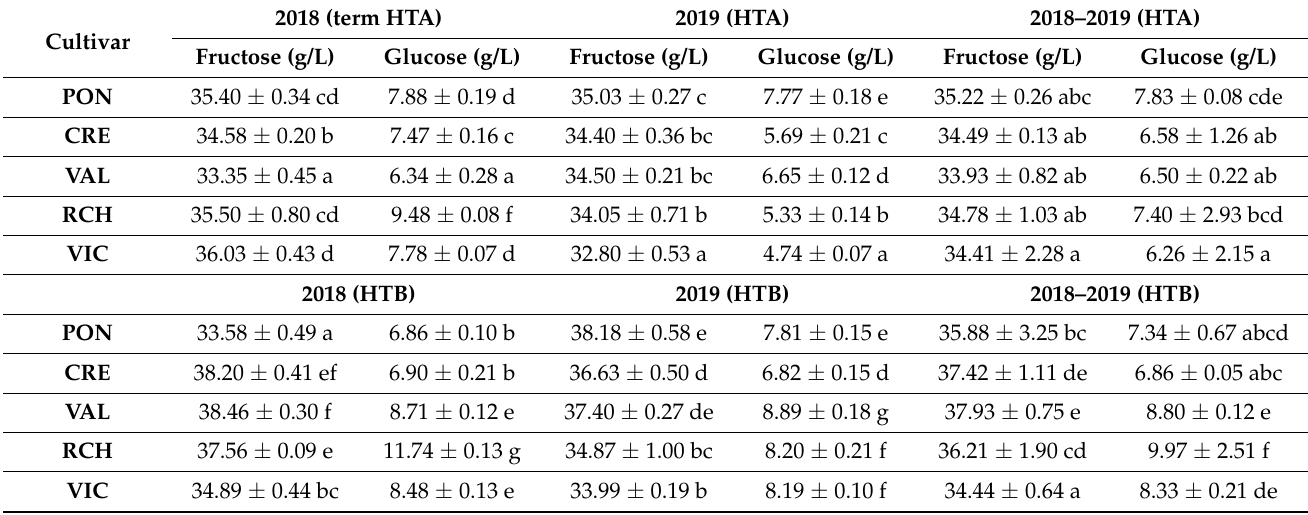
Values with different letters in columns are significantly different at p < 0.05 by LSD test in ANOVA (Statgraphic XVII). Abbreviations: PON, ‘Poncho’; CRE, ‘Canadian Red’; VAL, ‘Valentine’; RCH, ‘Red Champagne’; VIC,